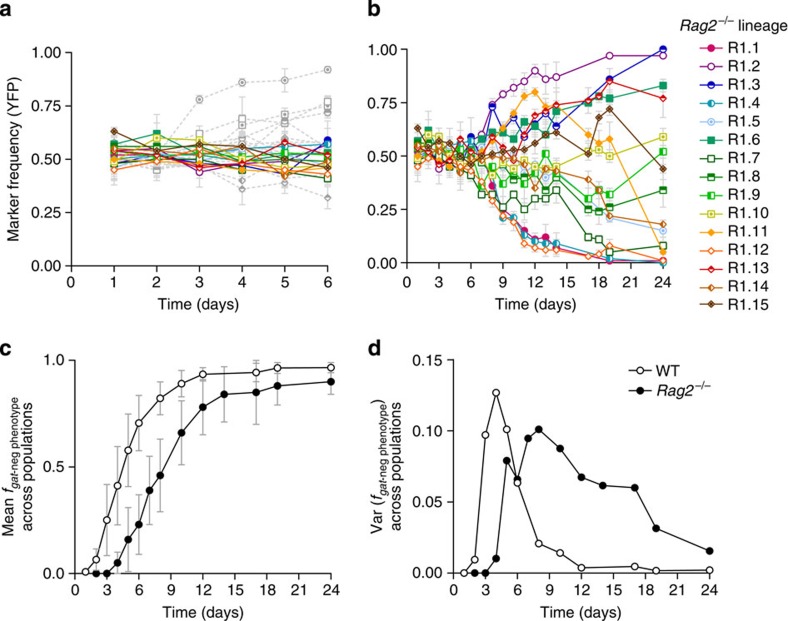
E. coli adapts at a slower pace in immune-compromised mice.Dynamics of marker frequency (±2 s.e.m., representing the error associated with the sampling when calculating the frequency of the marker) during the first 6 (a) or 24 (b) days of adaptation of E. coli upon colonization of Rag2−/− (coloured) or WT (grey) mice (reproduced from ref. 11 for clarity). (c) Average frequency of the gat-negative phenotype (±2s.e.m.) over time across WT (white) and Rag2−/− (black) animals (n=15, for each host genotype) and the variance for the frequency (d).